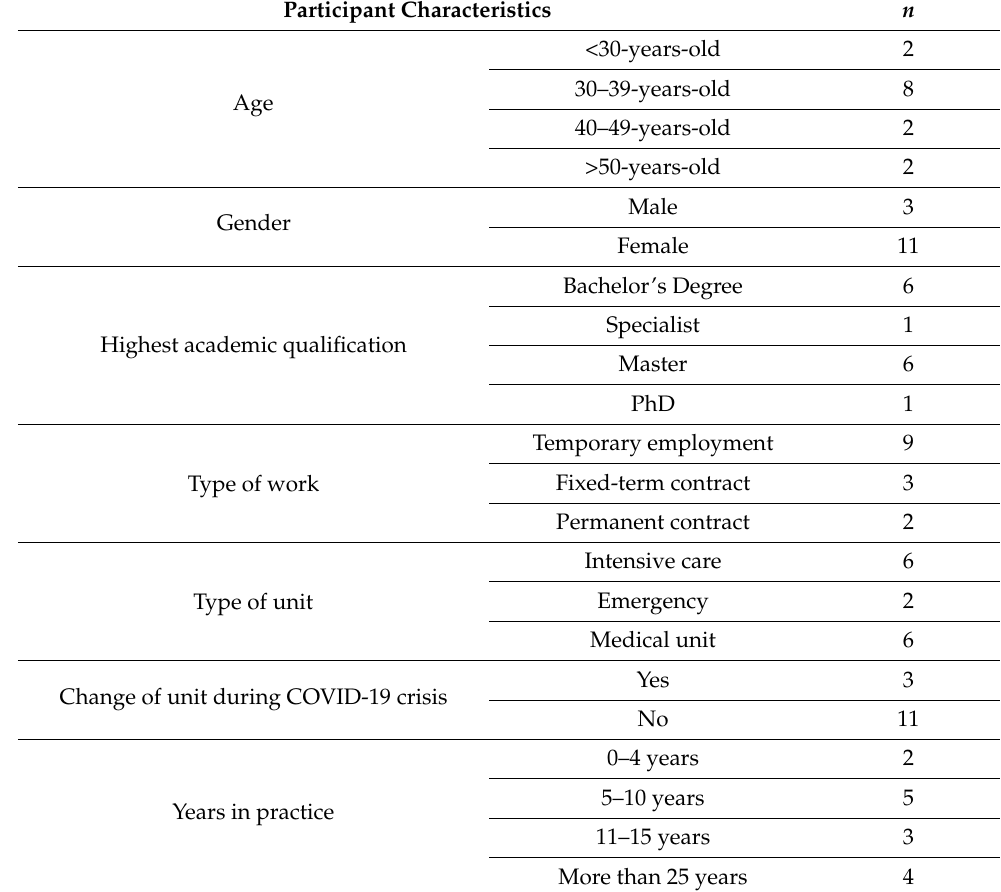
Table 1. Main characteristics of participants (N =